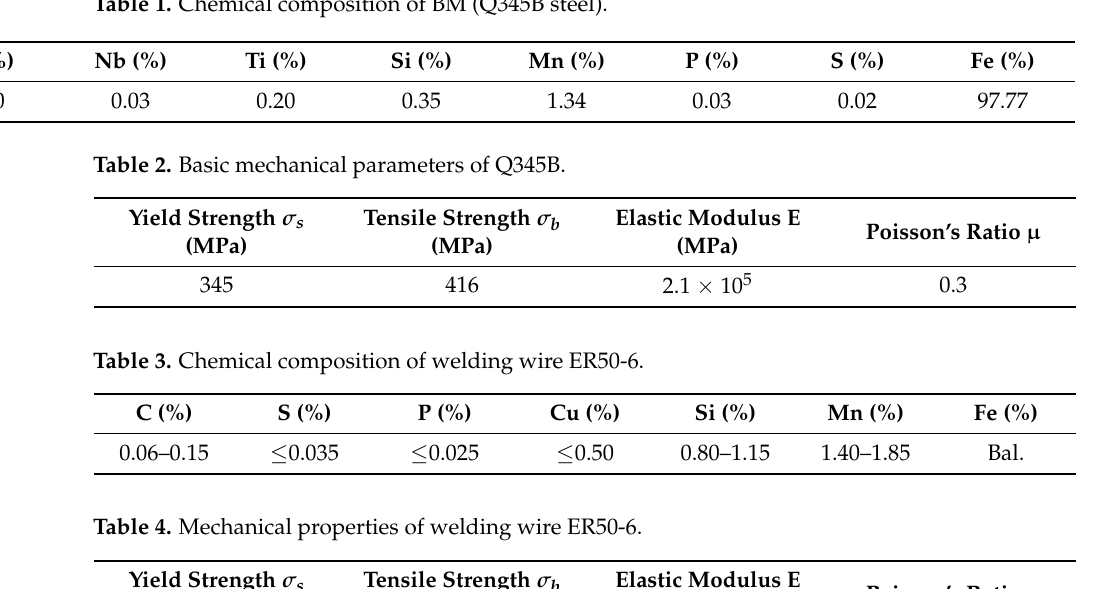
Table 1. Chemical composition of BM (Q345B steel).